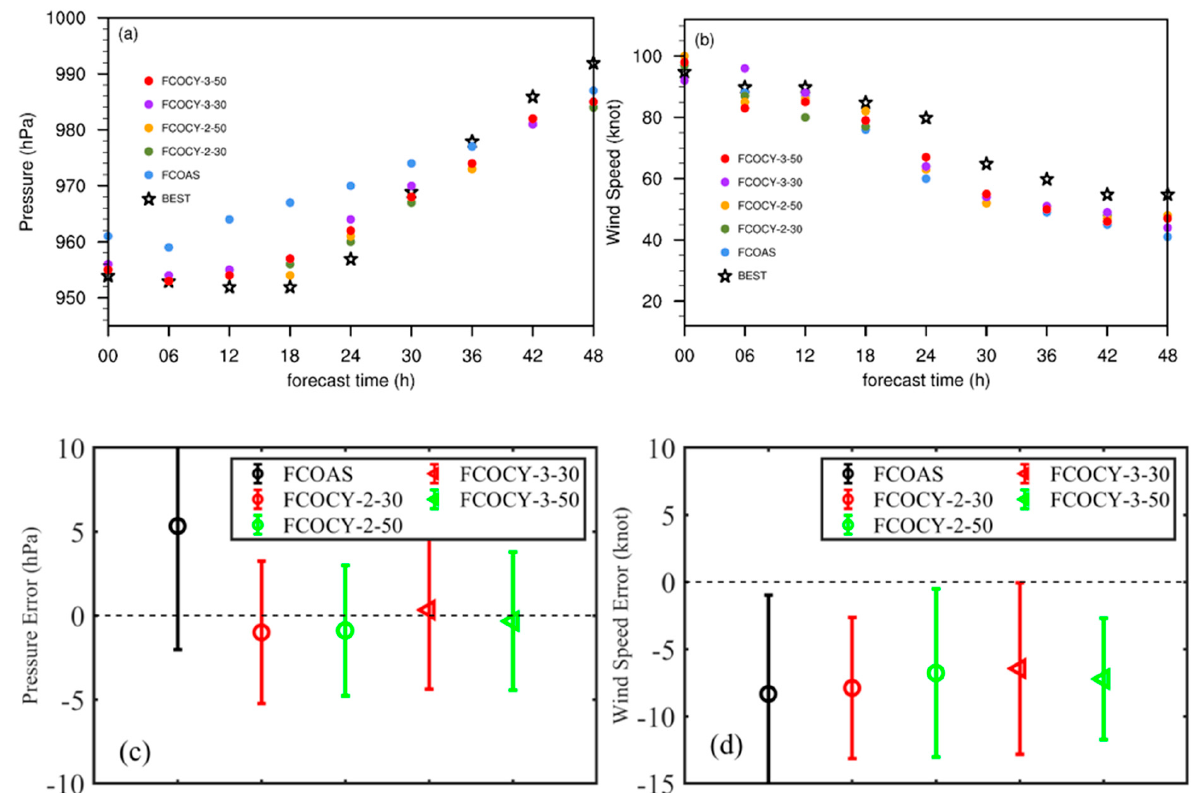
Figure 10. ( a , b ) Same as Figure 7, except for the time series of intensity for Florence from 1800 UTC on 9 to 1800 UTC on 11 October 2018; ( c , d ) Same as Figure 8, except for the 48-h average intensity errors for Florence. Figures show comparison and errors from different experiments (FCOCY-2-30,